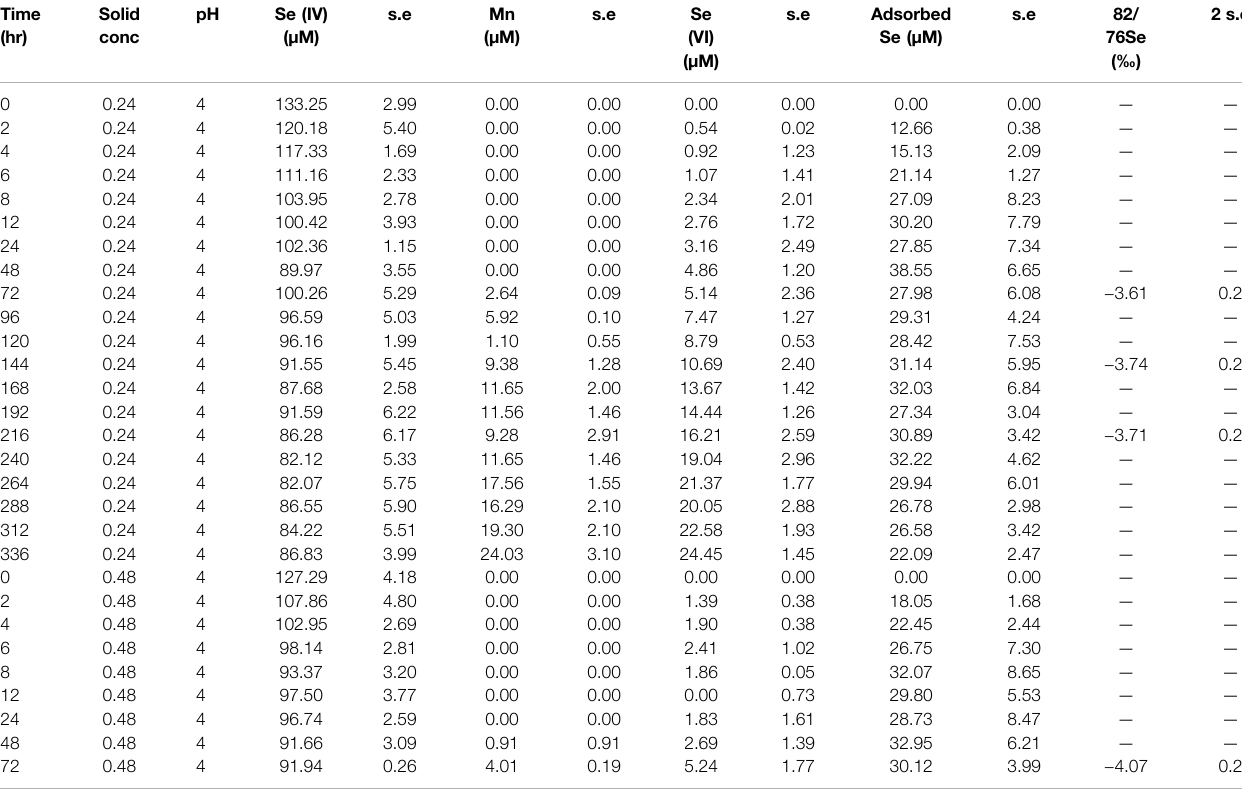
TABLE 2 | Concentration and isotope data for experiments carried out with AR